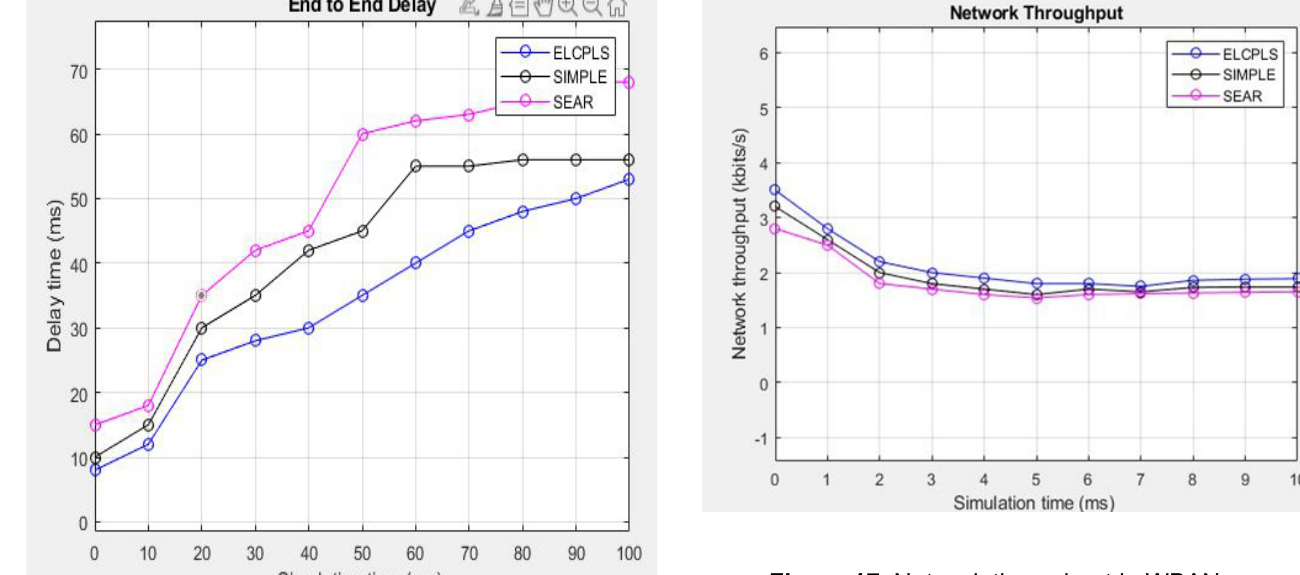
Figure 17. Network throughput in